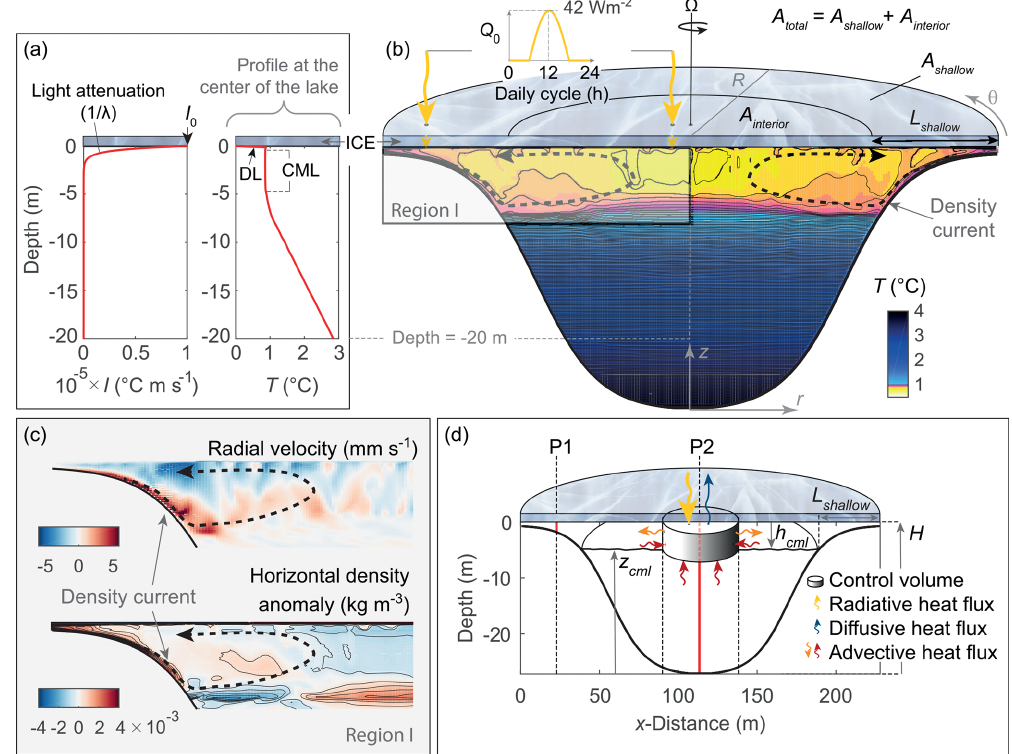
Figure 1. Schematic of the modeled lake forcing and under-ice differential heating. (a) Variation in depth of the radiative forcing ( I ) and the resulting temperature profile at the lake center, characterized by the formation of a convective mixed layer (CML) immediately below the thin diffusive layer (DL). (b) Daily cycle of the radiative heat flux and snapshot of the temperature field in a cross section showing gravity currents developing in the littoral region as a result of differential heating for Ro O (10 − 1 ) . The isotherm spacing is 0.02 ◦ C. (c) The signature of these gravity currents can also be detected by positive radial velocities (positive towards the lake interior) and positive horizontal density anomalies (deviations from the basin-average density profile). (d) Schematic of the mixed-layer heat balance at the lake interior and locations of profiles P1 and P2 (red lines), ∼ 91m apart, used in Fig. 2.